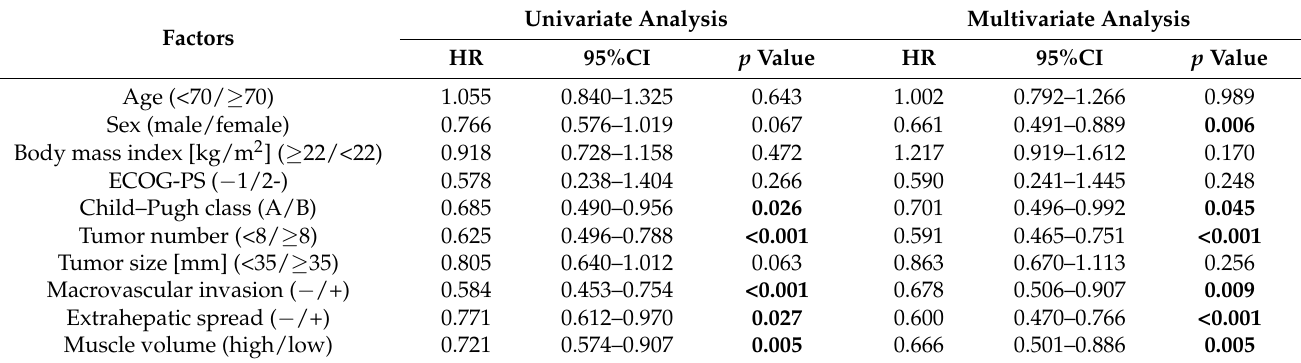
Table 3. Univariate and multivariate analyses for predictors of overall survival ( n =